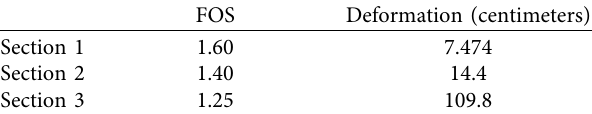
Figure 14: Dynamic load of seismic data with 2, 4, 6, and 8 seconds of sections 1, 2, and 3. Table 4: FOS with average rainfall during